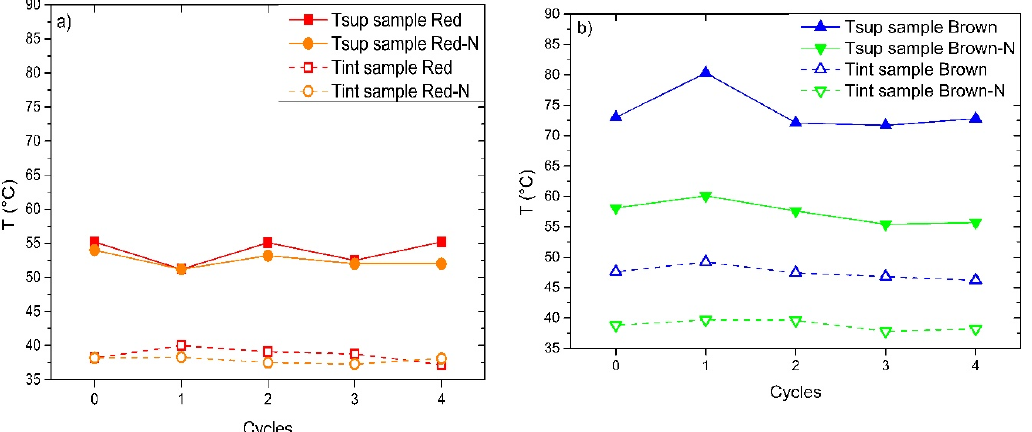
Figure 10. Plateau temperature of ( a ) red coatings and ( b ) brown coatings as a function of degradation